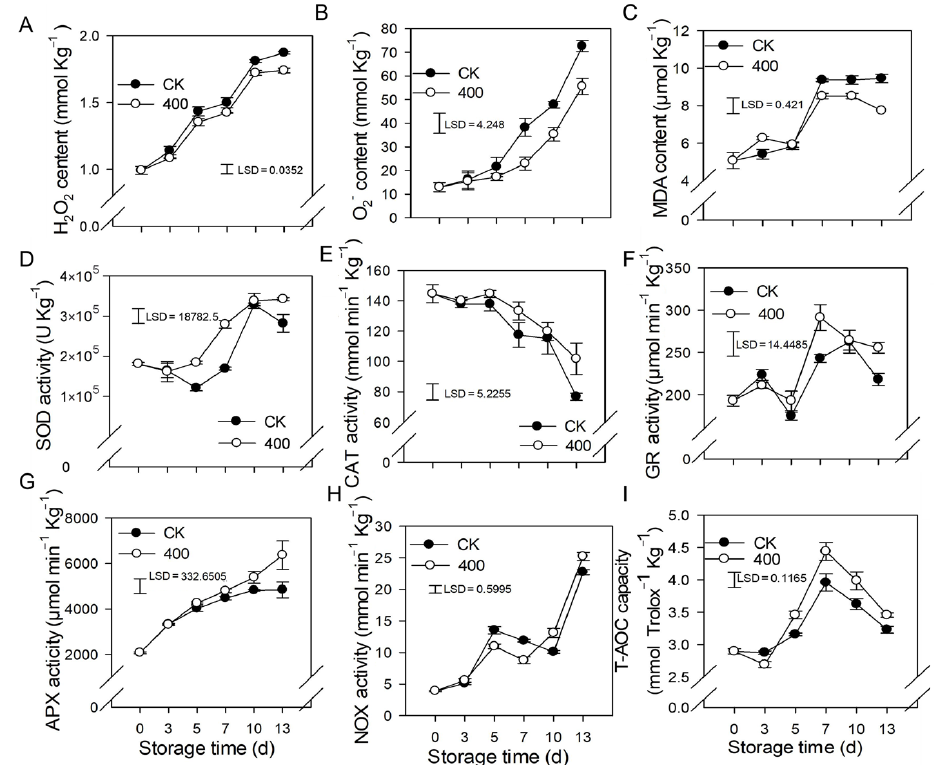
Figure 3. Effects of melatonin on the metabolism of reactive oxygen species in papaya fruit. ( A ) Impact of melatonin treatment on H 2 O 2 ( B ), and O 2 − contents in papaya fruit. ( C ), the effect of melatonin treatment on MDA ( D ), SOD ( E ) CAT ( F ) GR ( G ) APX ( H ) NOX ( I ) and T-AOC capacity in papaya fruits. Each data point represents the mean ± SE ( n = 3). Least significant differences (LSDs) were calculated to compare significant effects at the 5% level. CK: control group, “400” indicated the “400 µ molL − 1 ” melatonin treatments.